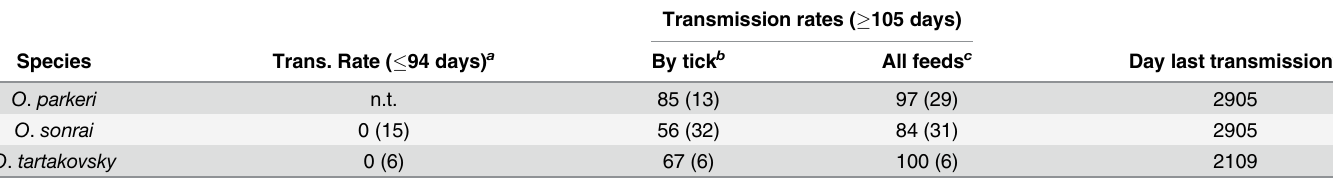
Table 1. Transmission of Karshi virus by Ornithodoros ticks after feeding on mice with a viremia about 10 6.5 SMLD 50 /ml of blood.